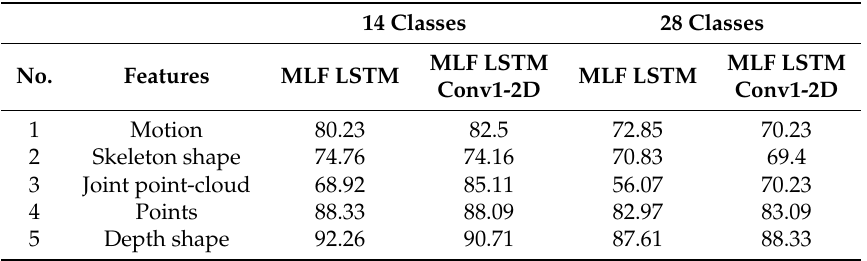
Table 6. Performance results of the two models using the separate hand